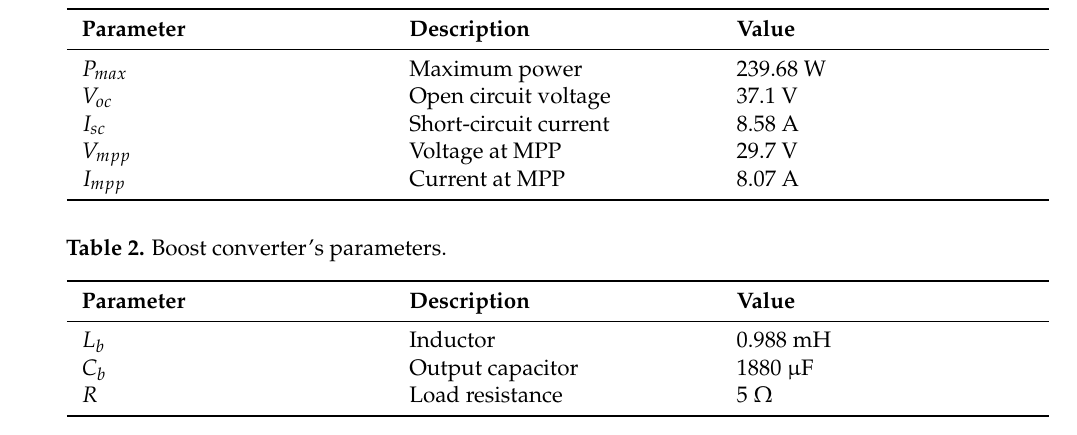
Table 1. Parameters of PV panel 1Soltech 1STH-240-WH.